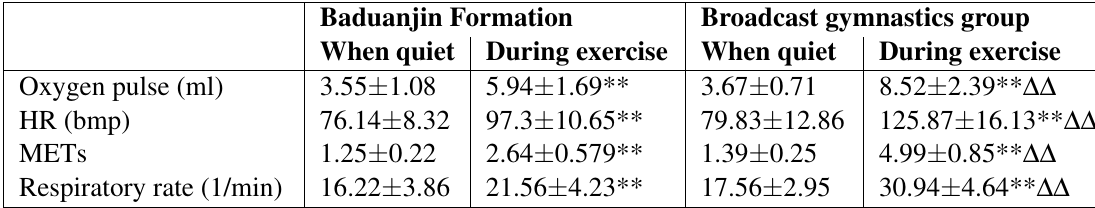
Table 2 Exercise Intensity of Baduanjin and Ninth Broadcast Gymnastics